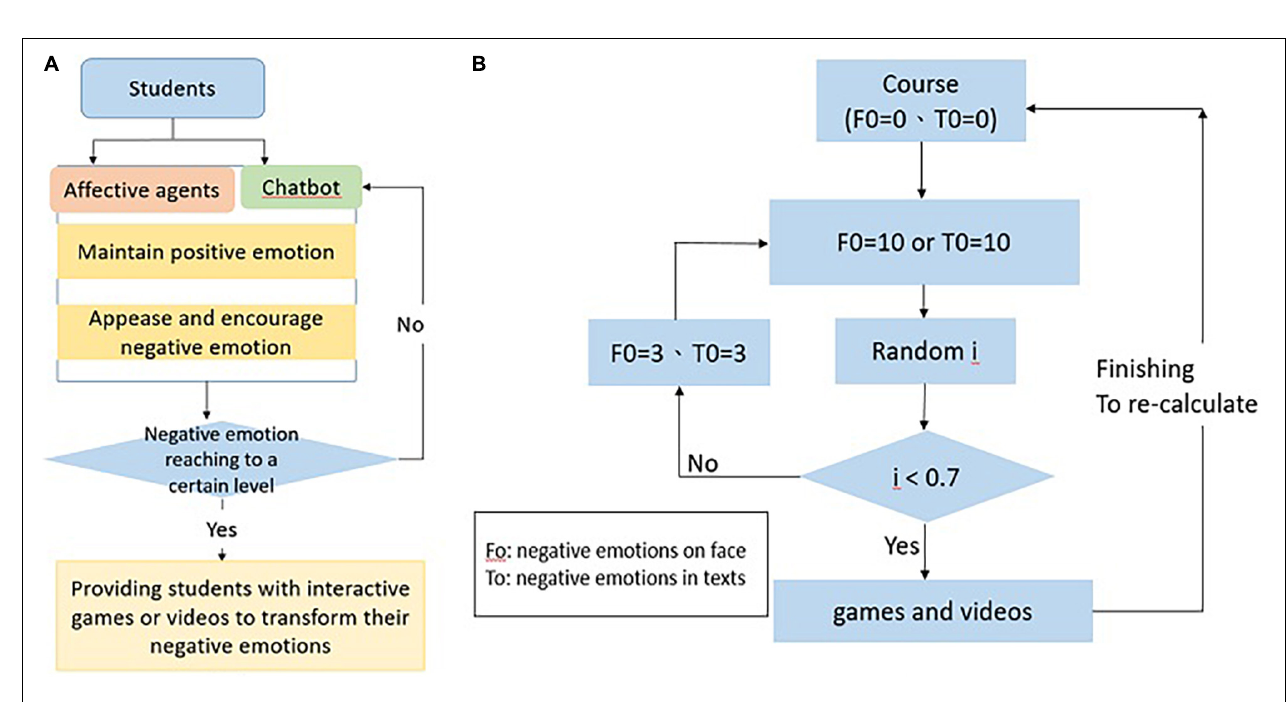
FIGURE 2 | (A,B) The system algorithm